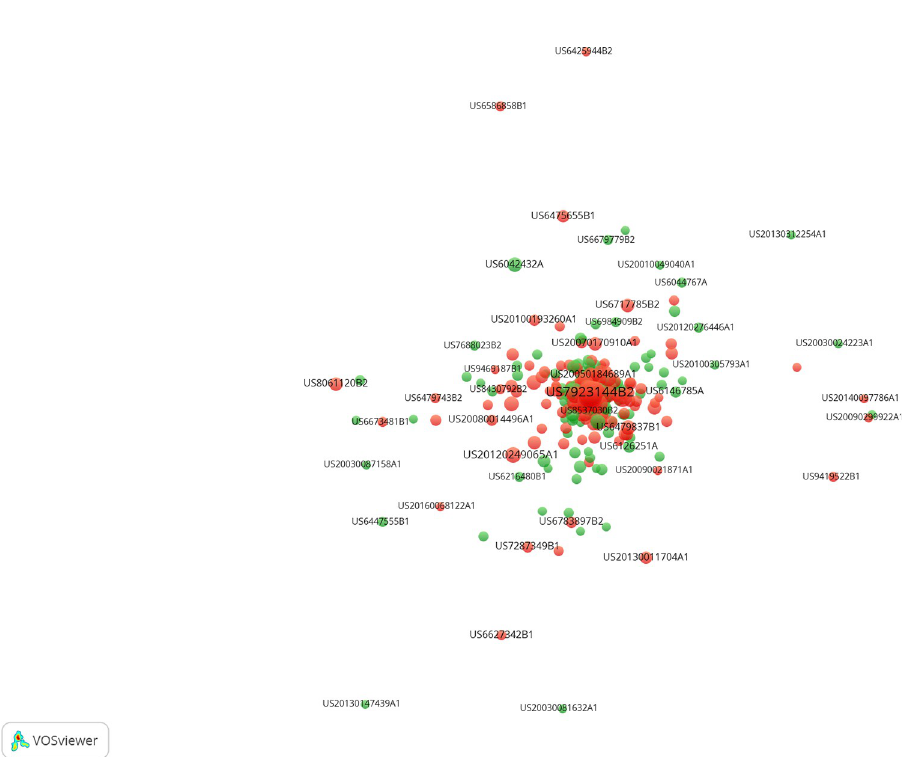
Fig 4. The central part of citation-base map of the EV patents. The highly cited in 3 years are marked in red, and the non-highly cited ones are marked in green.